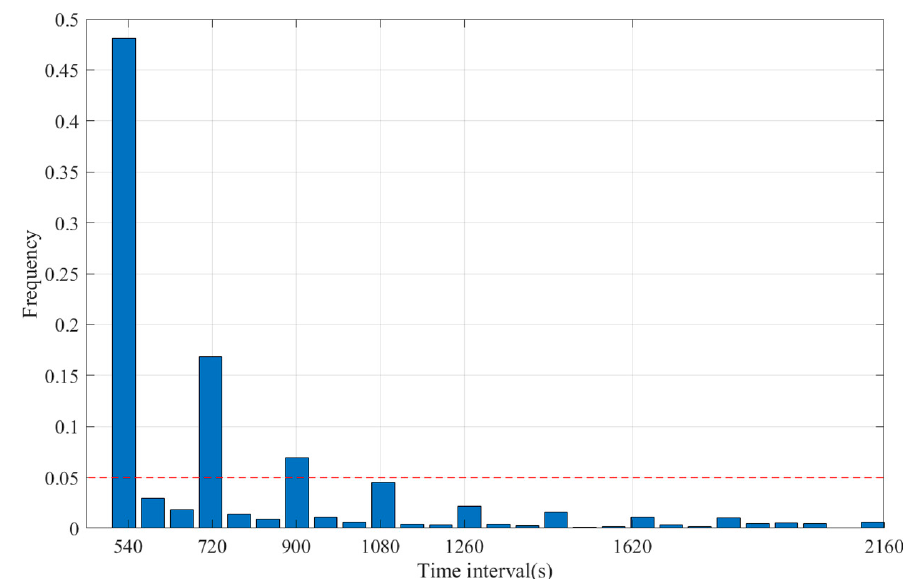
Figure 7. Time interval statistics of adjacent data of the same ship.